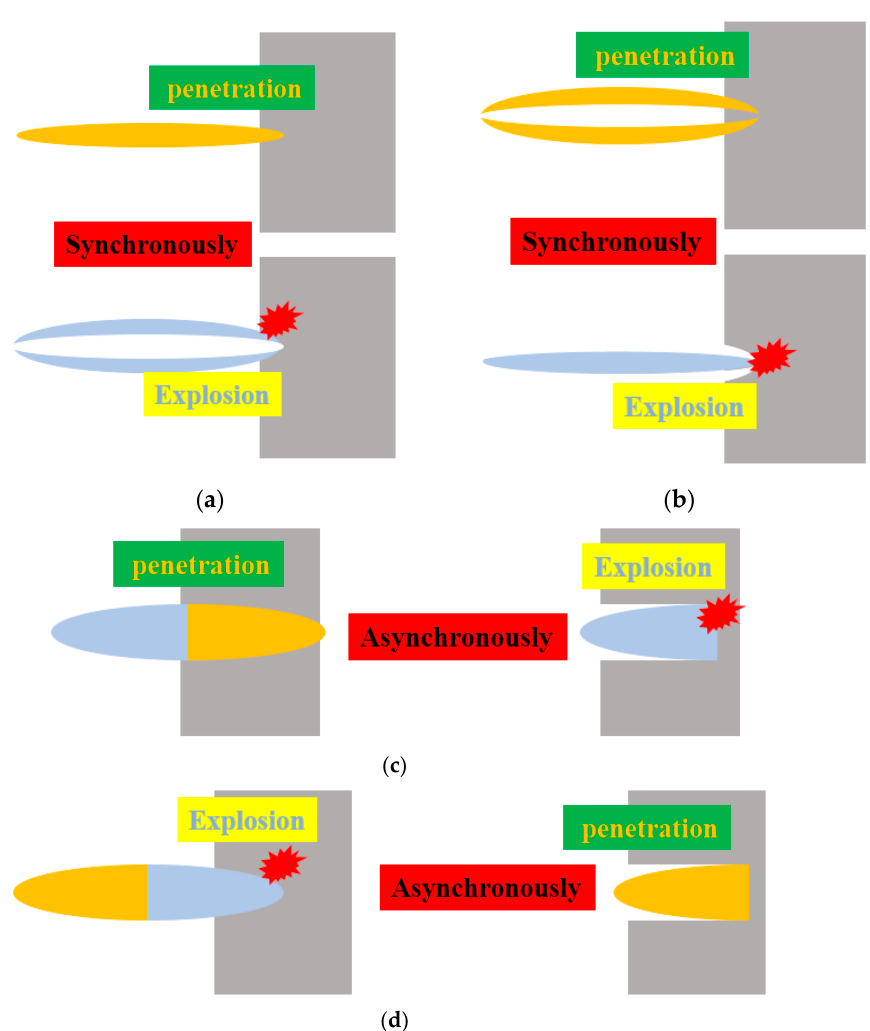
Figure 2. PE effects of different distributed jets: ( a ) Inner Cu and outer Al; ( b ) Outer Cu and inner Al; ( c ) Front Cu and rear Al; ( d ) Front Al and rear Cu.